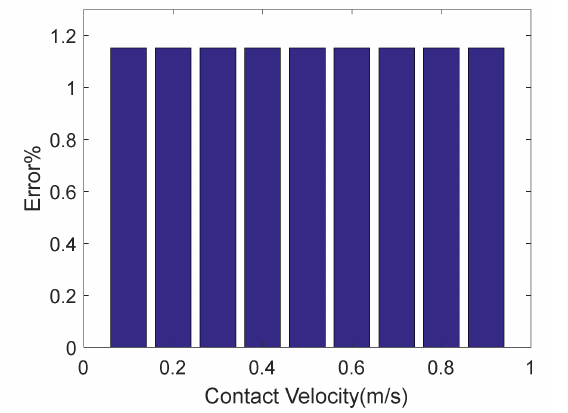
Figure 4. Errors with different stiffness parameters (